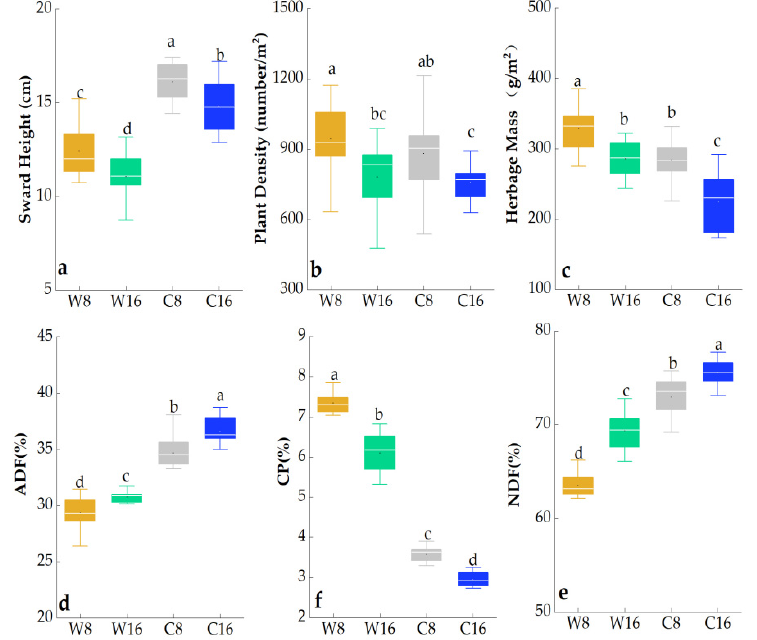
Figure 2. E ff ects of grazing seasons (warm and cold) and stocking rates (8 sheep / ha and 16 sheep / ha) Figure 2. Effects of grazing seasons (warm and cold) and stocking rates (8 sheep/ha and 16 on mean ( ± standard error (SE)) plant community characteristics and chemical composition in the sheep/ha) on mean (± standard error (SE)) plant community characteristics and chemical two years (2010 and 2011). Means within a column with di ff erent letters significantly di ff er ( p < 0.05). composition in the two years (2010 and 2011). Means within a column with different letters Di ff erent lowercase letters indicate significant di ff significantly differ ( p < 0.05). Different lowercase letters indicate significant differences.